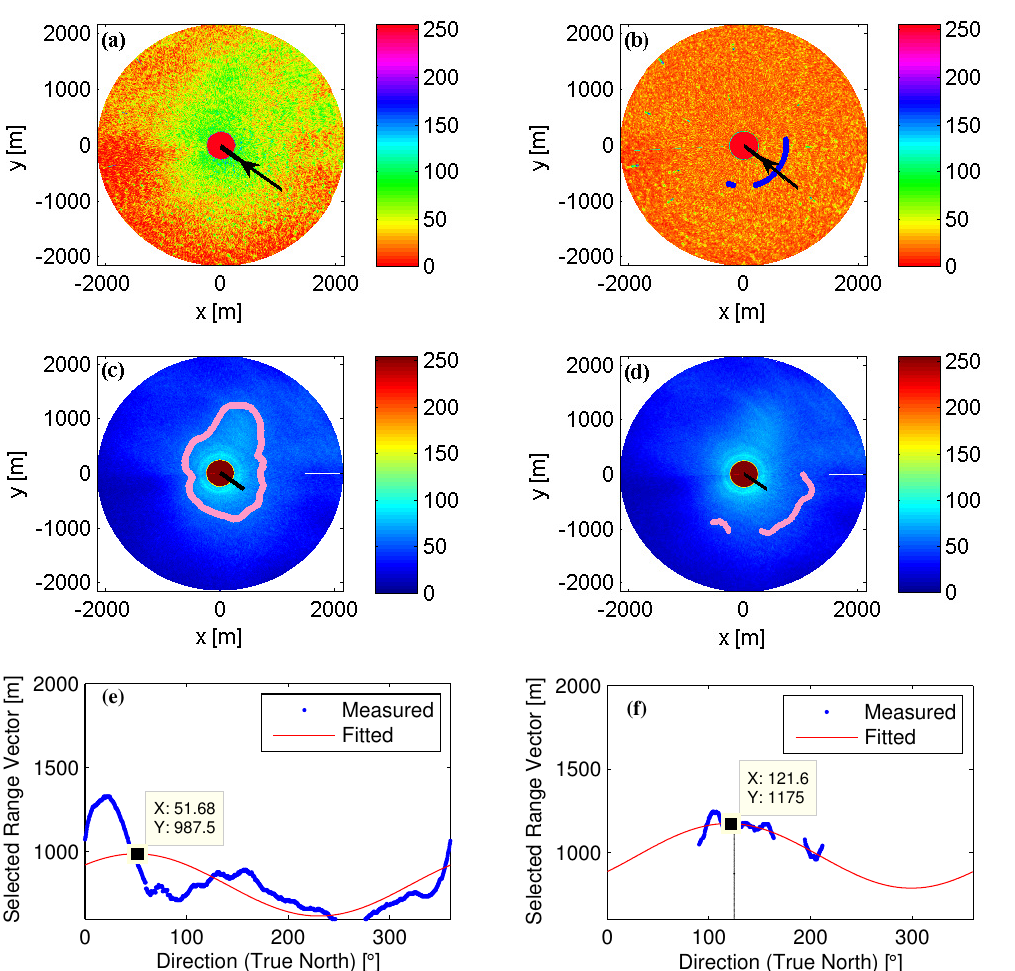
Figure 3. An illustrative example. ( a ) the original radar image with a ZPP of 0.5%; ( b ) the texture map with an RRP of 73%; and the distribution of selected range distances vector r i : ( c ) on an integrated image (without rain mitigation); ( d ) on an integrated image (with rain mitigation); ( e ) curve-fitting without rain mitigation; ( f ) curve-fitting with rain mitigation. The black bar at the center shows the anemometer-measured wind direction (125 ◦